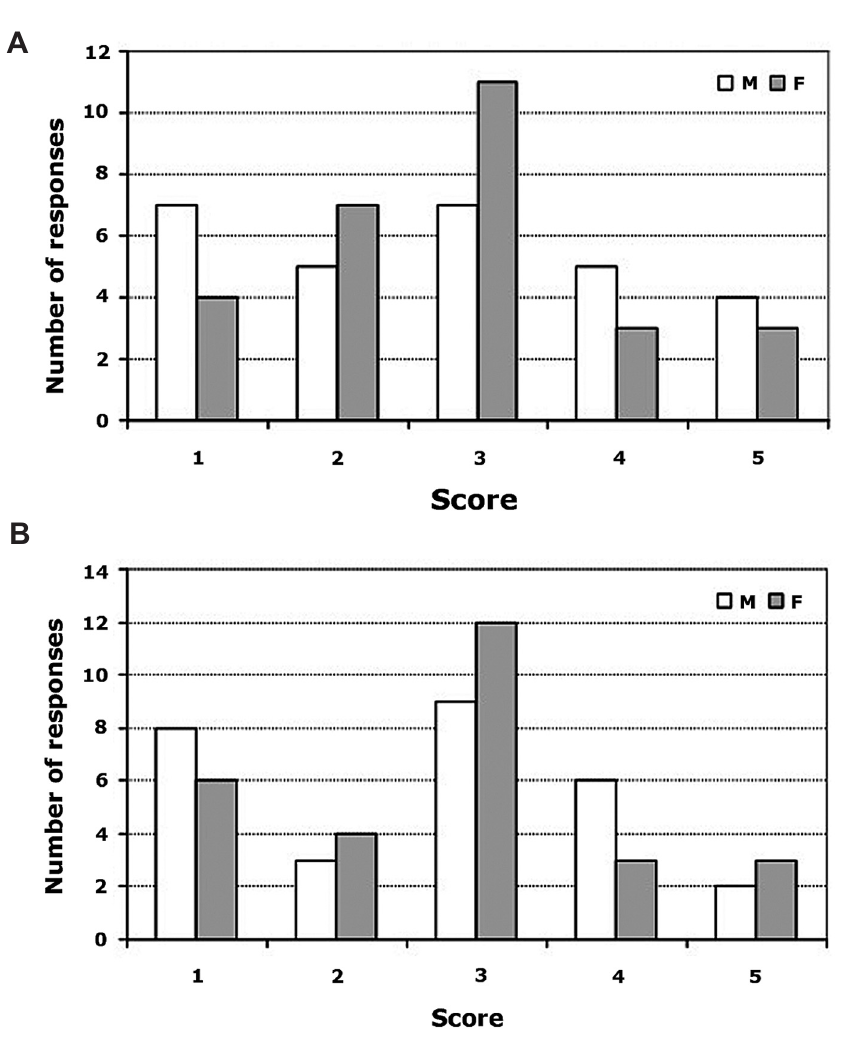
Figure 1 – Distribution of patient and partner responses on a 1-5 scale (ex.: 5 - very high, 4 - high, 3 - moderate, 2 - low, 1 - very low or not at all). M - male patients, F - female partners. Libido domain. A) Question 1: “Over the last 4 week are you happy with your level of sexual desire or interest?”. B) Question 2: “Over the last 4 weeks, are you happy with the level of sexual desire or interest of your